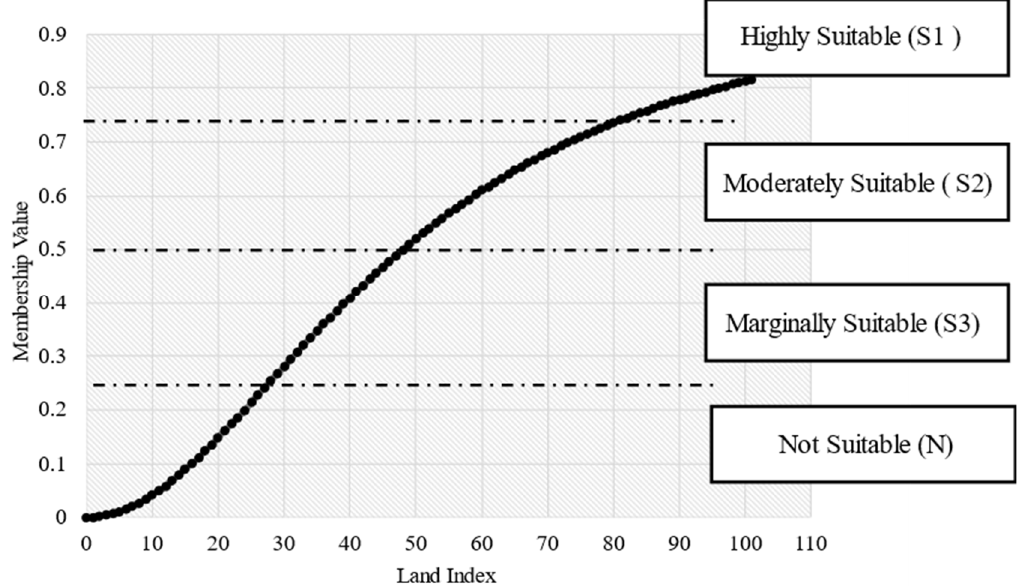
Figure 5. Selection of suitability classes for vineyard location using a fuzzy membership function and land index. Table 1. Variable selections and their explanation for specifications that included data types and sources.